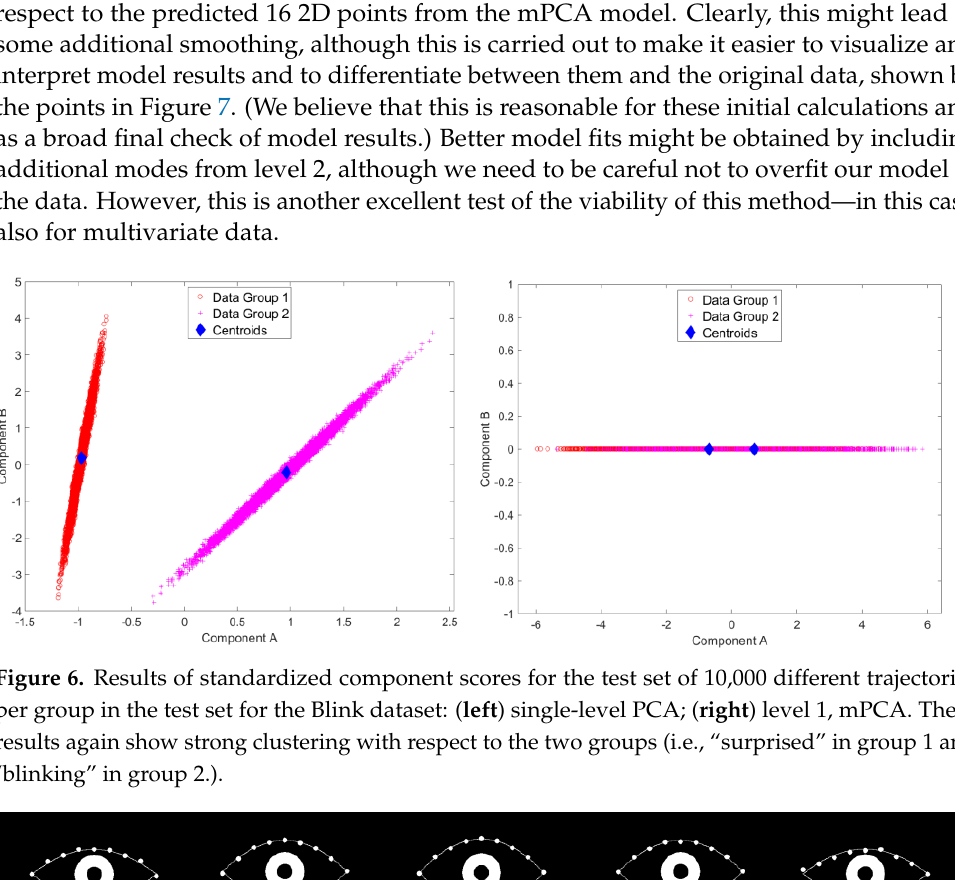
Figure 7. mPCA model fits (full lines) to entire trajectories (going from left to right in the images above) of the 16 2D landmark points of 2 specific examples chosen randomly from the test set: (upper row of images) from group 1: an eye “showing surprise,” i.e., the eye opens wider before returning to normal; (upper row of images) from group 2: an eye “blinking,” i.e., the eye closes before returning to normal. (The iris is added as an illustration only.)